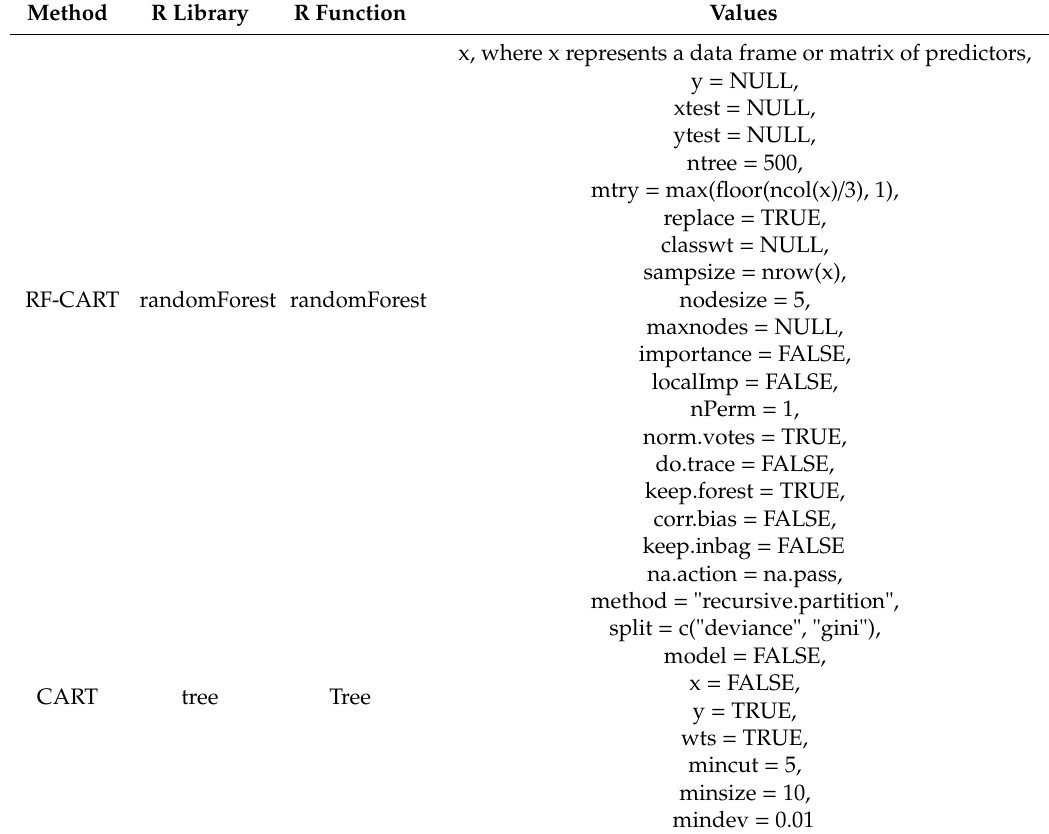
Table 3. R packages and respective default values for bootstrapped regression